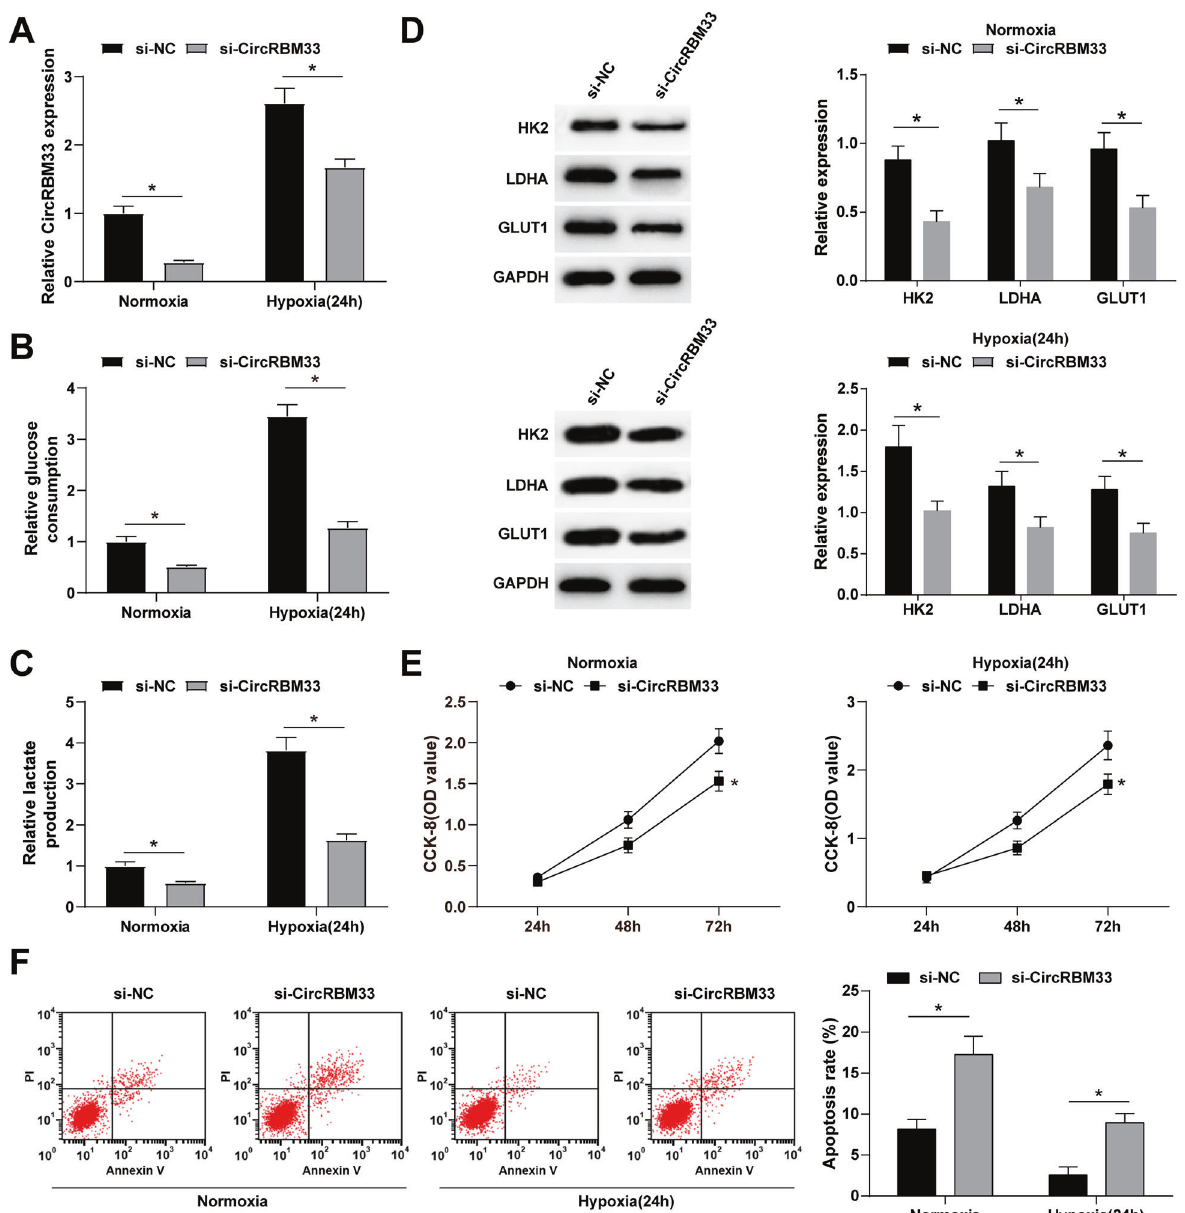
knocking down circRBM33; D Western blot detected HK2, LDHA and GLUT1 expression in MCF-7 cells after knocking down circRBM33; E CCK-8 detected MCF-7 cell proliferation after knocking down circRBM33; F Flow cytometry detected MCF-7 cell apoptosis after knocking down circRBM33 (Under normoxia, the apoptotic rate increased from 8.15% to 17.25% after knocking down circRBM33; Under hypoxia, the apoptotic rate increased from 2.58% to 8.95% after knocking down circRBM33); * P < 0.05. Data were expressed in the form of mean ± standard deviation (Repetitions = 3). The comparison between two groups should be performed by t